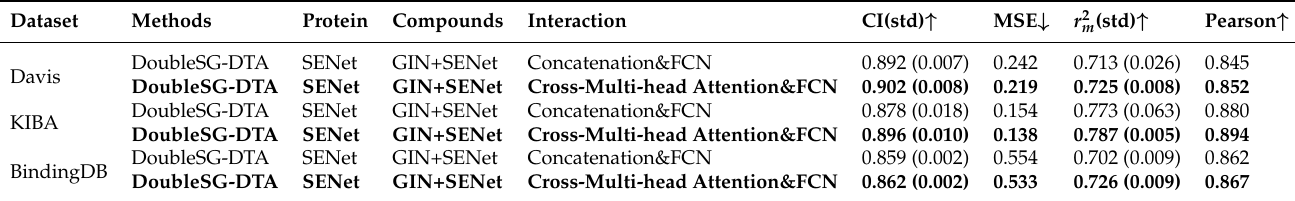
Table 7. Investigating the contributions of the cross-multi-head attention mechanism on Davis, KIBA, and BindingDB